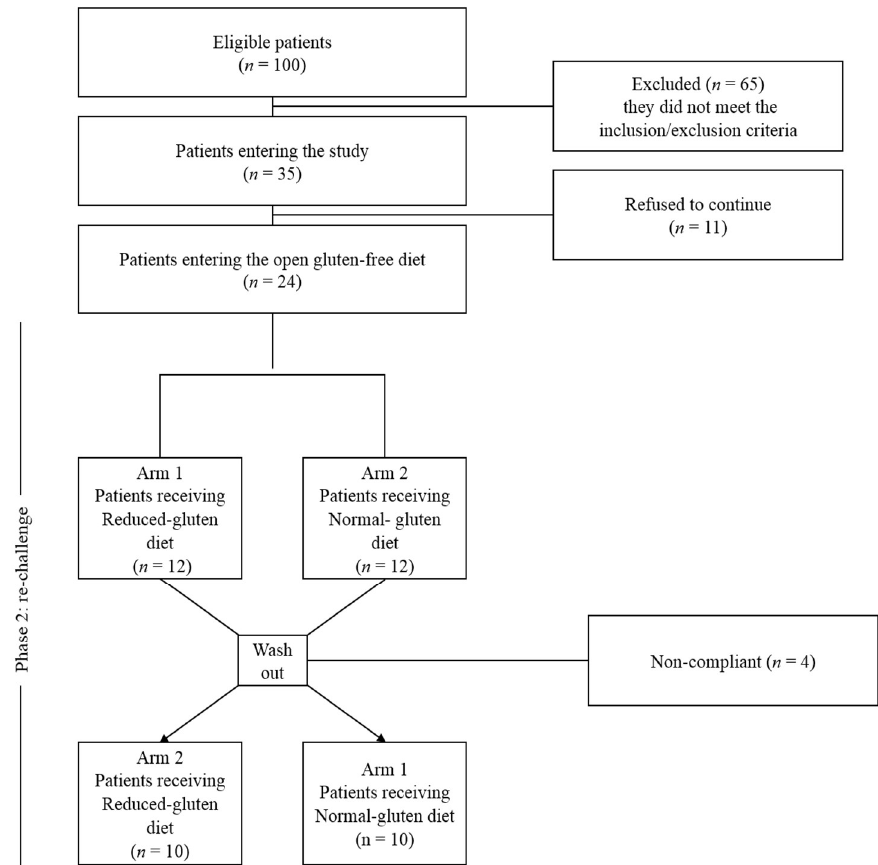
Figure 3. Flow diagram of patients into the trial from eligibility to the end of gluten challenge.